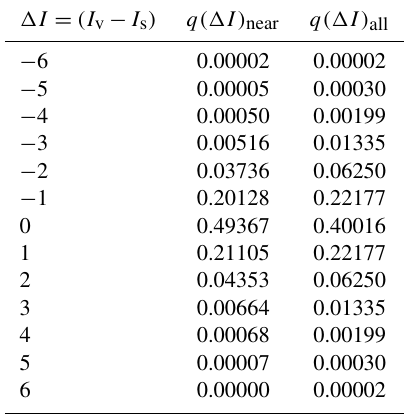
Table 1. Values of q(I v | I s ) expressed as the probability that site in- tensity I s differs by (cid:49)I from the intensity I v observed at the nearest locality within 20km ( q((cid:49)I) near ) and at all the neighboring locali- ties within 20km ( q((cid:49)I) all